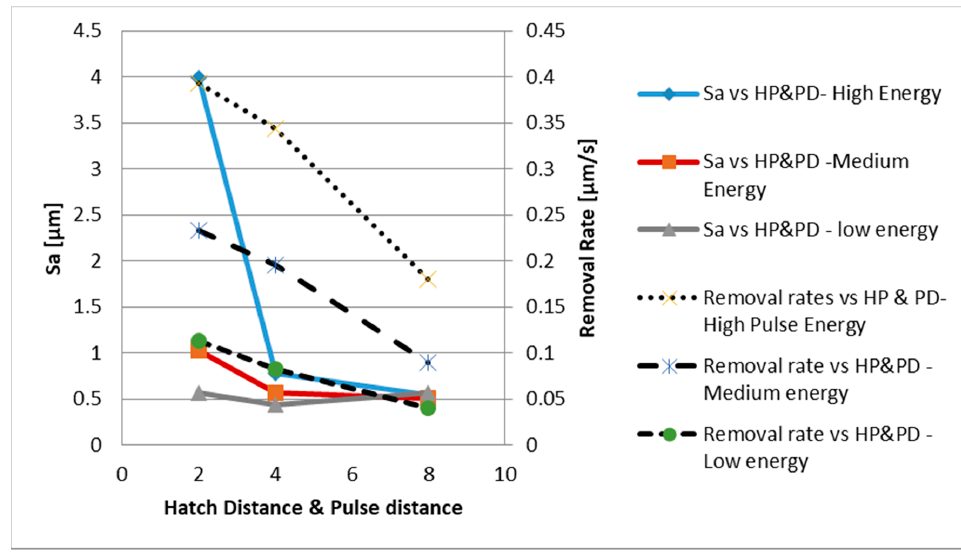
Figure 7. Optimisation of laser parameters to obtain a low Sa (average surface roughness) and high removal rates.